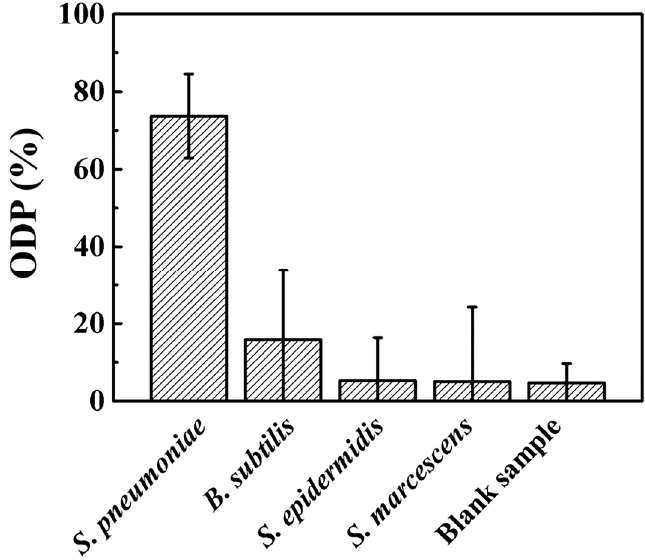
Figure 5. The selectivity of the nanoparticle decoration method using the PnC antibody. Error bars represent the 95% confidence intervals.